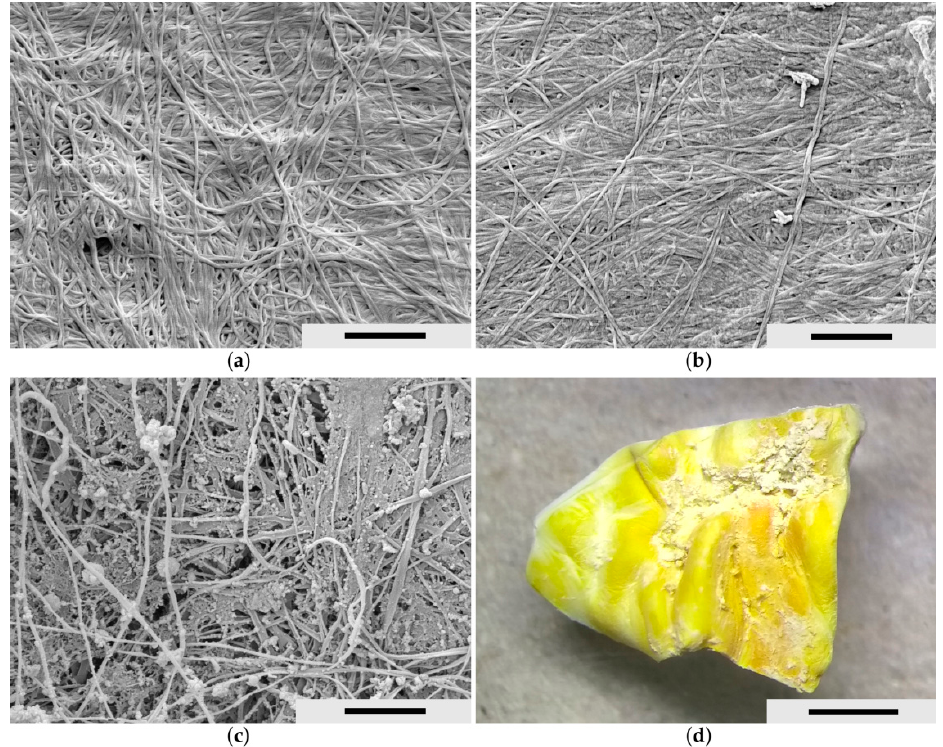
Figure 3. Scanning electron microscopic images ( a – c ) and photographic image ( d ) of biocellulose materials used for bile duct implants. ( a ) Luminal surface of biocellulose tube V4 before treatment with bile; ( b ) biocellulose tube V4 after in vitro exposition to bile; ( c ) biocellulose tube V3 after explantation following animal experiments; ( d ) a section of the explanted biocellulose tube V3 showing the inner surface. Scale bars: 2 µm ( a – c ) and 2 mm ( d ).